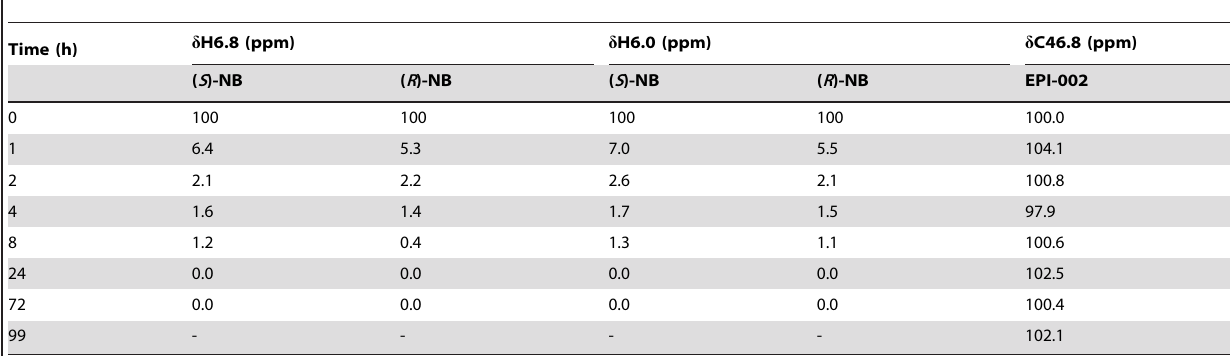
Table 2. Relative Intensity of ( S )-, ( R )-Niphatenone B, and EPI-002.